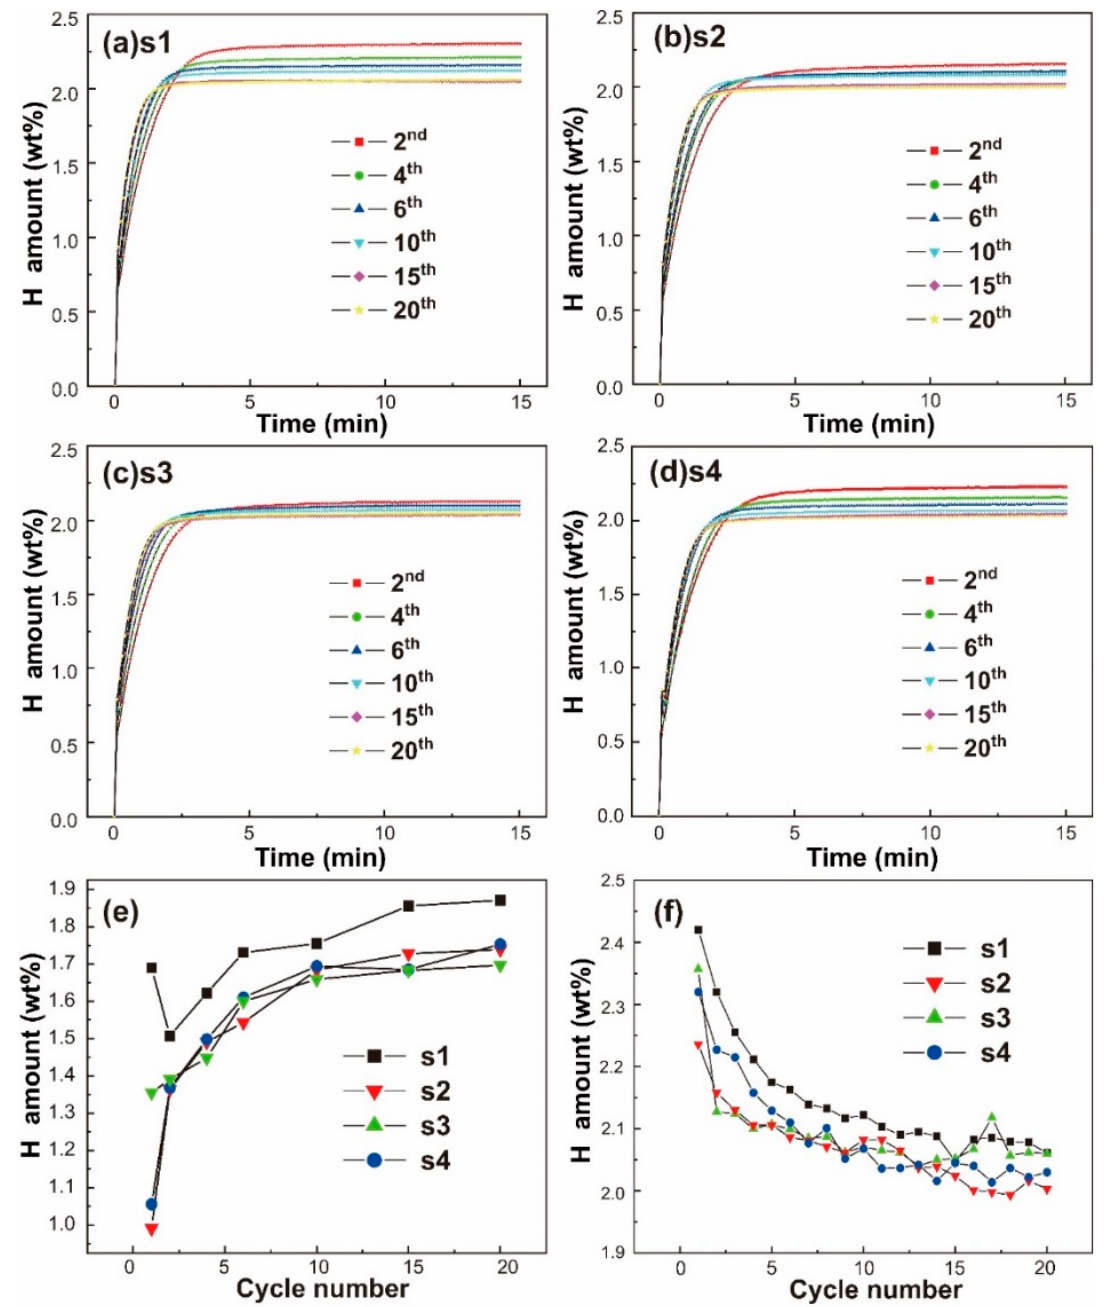
Figure 3. ( a – d ) Hydrogen absorption kinetics of sample s 1 to s 4 , ( e ) hydrogen absorption amounts within the first minute in different cycles, and ( f ) reversible hydrogen absorption amount from the 1st to the 20th cycle for samples s 1 to s 4